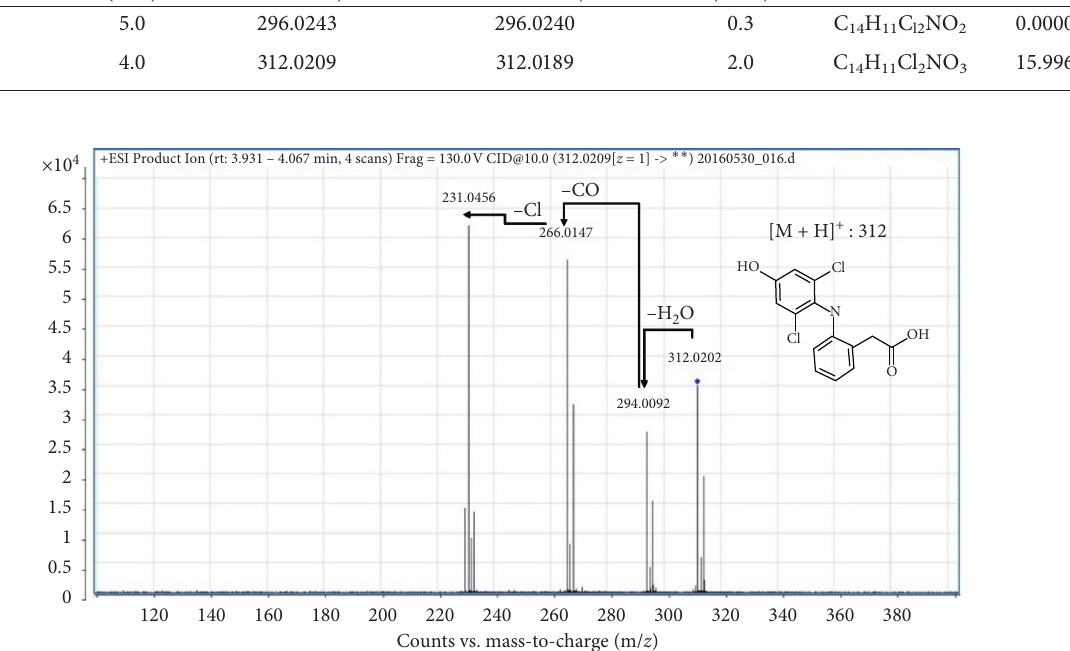
Figure 3: (+) ESI-QqToF-product ion spectra of 4 ′ -OH-DCF, [M +H] + � m / z 312; CE �